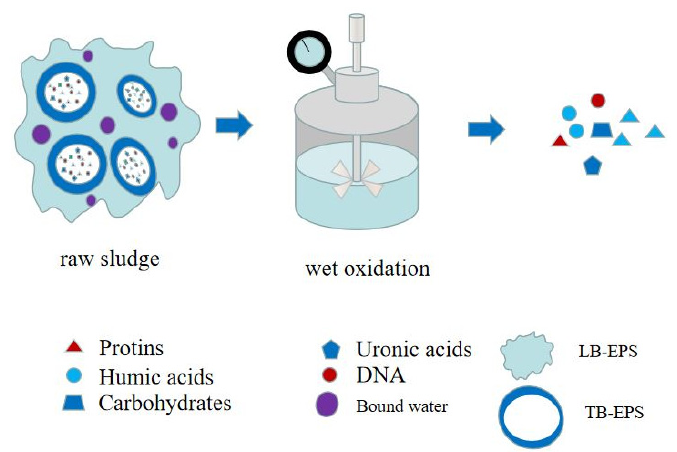
Figure 5. WAO pretreatment enhances sludge dewatering